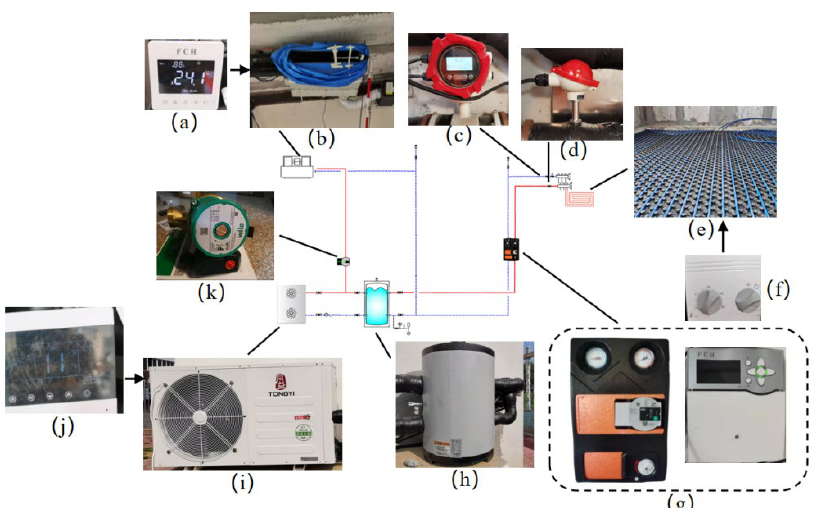
Figure 5. Illustrated schematic of the cooling system, ( a ) temperature controller of fan coil, ( b ) fan